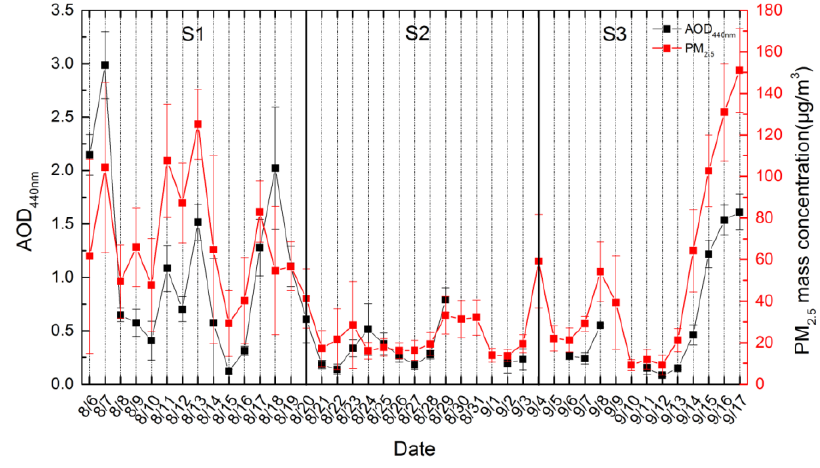
Figure 2. Daily mean values of AOD 440nm and PM 2.5 .